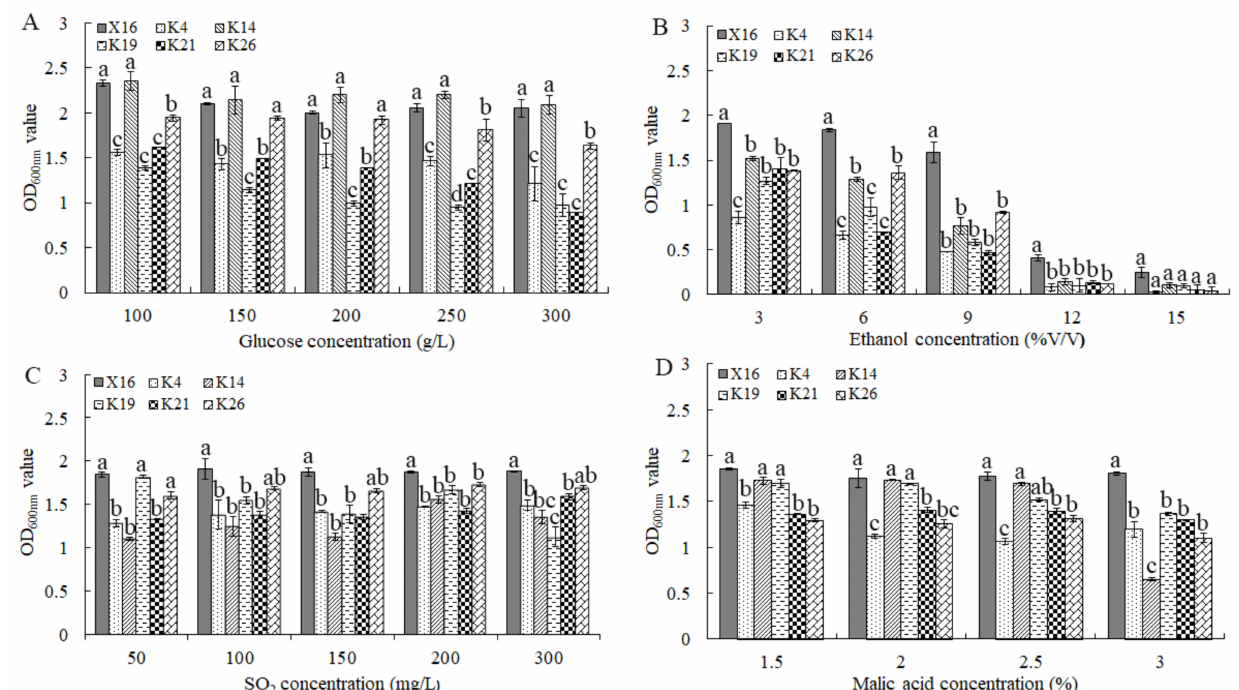
Figure 4. Properties of oenological condition tolerances of the selected yeasts isolated from KFP. ( A ) Glucose tolerance, ( B ) ethanol tolerance, ( C ) SO 2 tolerance, and ( D ) malic acid tolerance. Different lowercase letters above the standard deviation bar indicate a significant difference ( p <